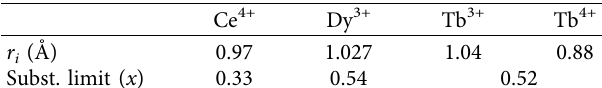
Figure 5: Fluorite formula’s volume variation with the Nd Table 2: Substitution limits of the Nd 5 − x Ln x Mo 3 O 16+ δ series, where Ln � Ce, Dy, Tb, and ionic radii of doping elements.